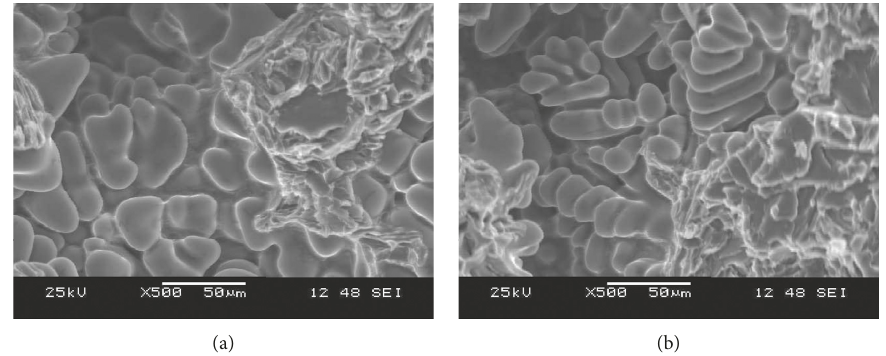
Figure 11: The FESEM of LM 25-B 4 Cnp-Grnp hybrid composites. (a) LM 25-5% B4Cnp-5% Grnp. (b) LM 25-10% B4Cnp-10%